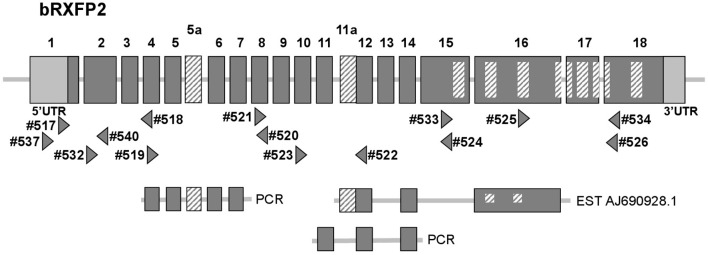
Schematic exon organization of the bovine RXFP2 gene (above) indicating both the position of the novel exons 5a and 11a, and the locations of the oligonucleotide primers (triangles) used for RT-PCR analysis. The locations of encoded transmembrane regions are indicated by the internal cross-hatched rectangles. The corresponding exon structures of various splice variants identified in this study by RT-PCR, or as a pre-existing EST sequence, are indicated below.